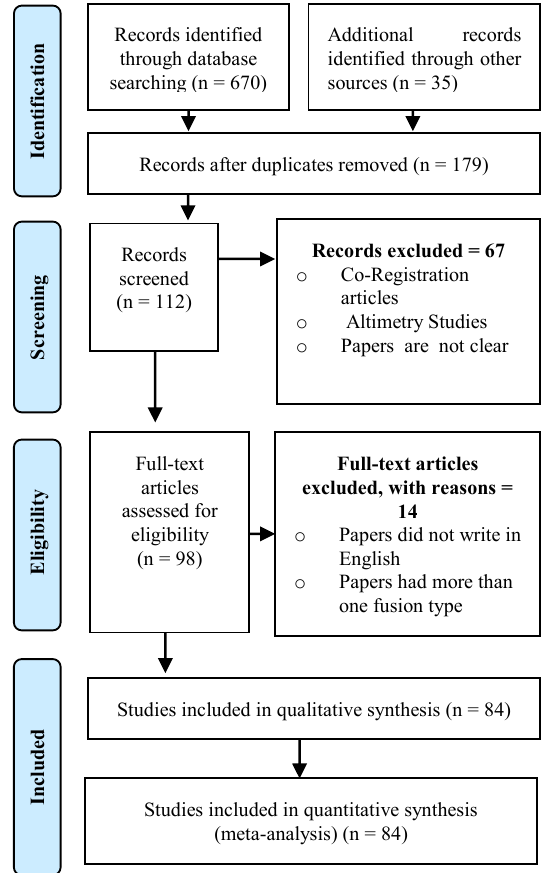
Figure 1: Methodology of work (the PRISMA